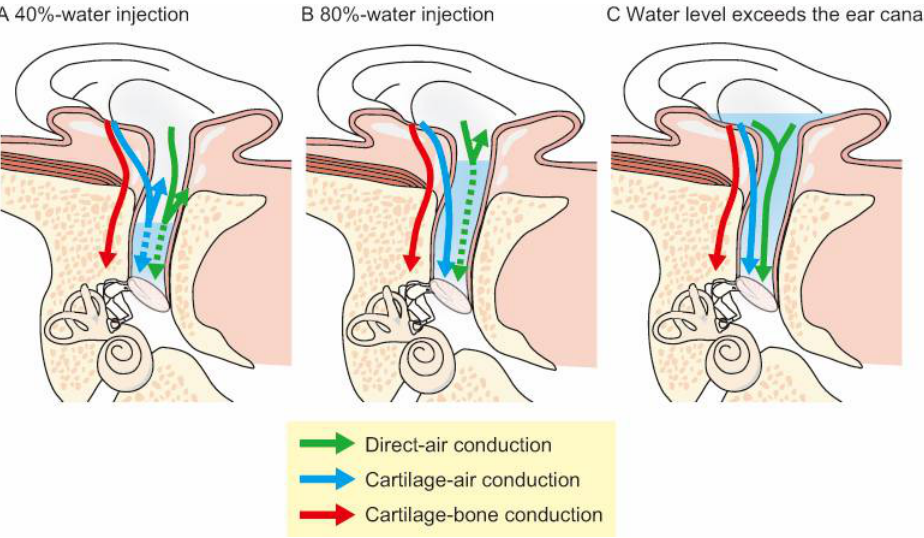
Figure 3. Effects of ear canal water injection on the transmission pathways. ( A ) The water stays within the bony portion of the ear canal, interrupting direct- and cartilage–air conduction. ( B ) The water enters the cartilaginous portion of the ear canal, avoiding an impedance mismatch between air and water in the cartilage-AC pathway. ( C ) The water level exceeds the ear canal, allowing for direct water vibrations. (Figure 3 was originally presented in Nishimura et al. 2015, Figure 1